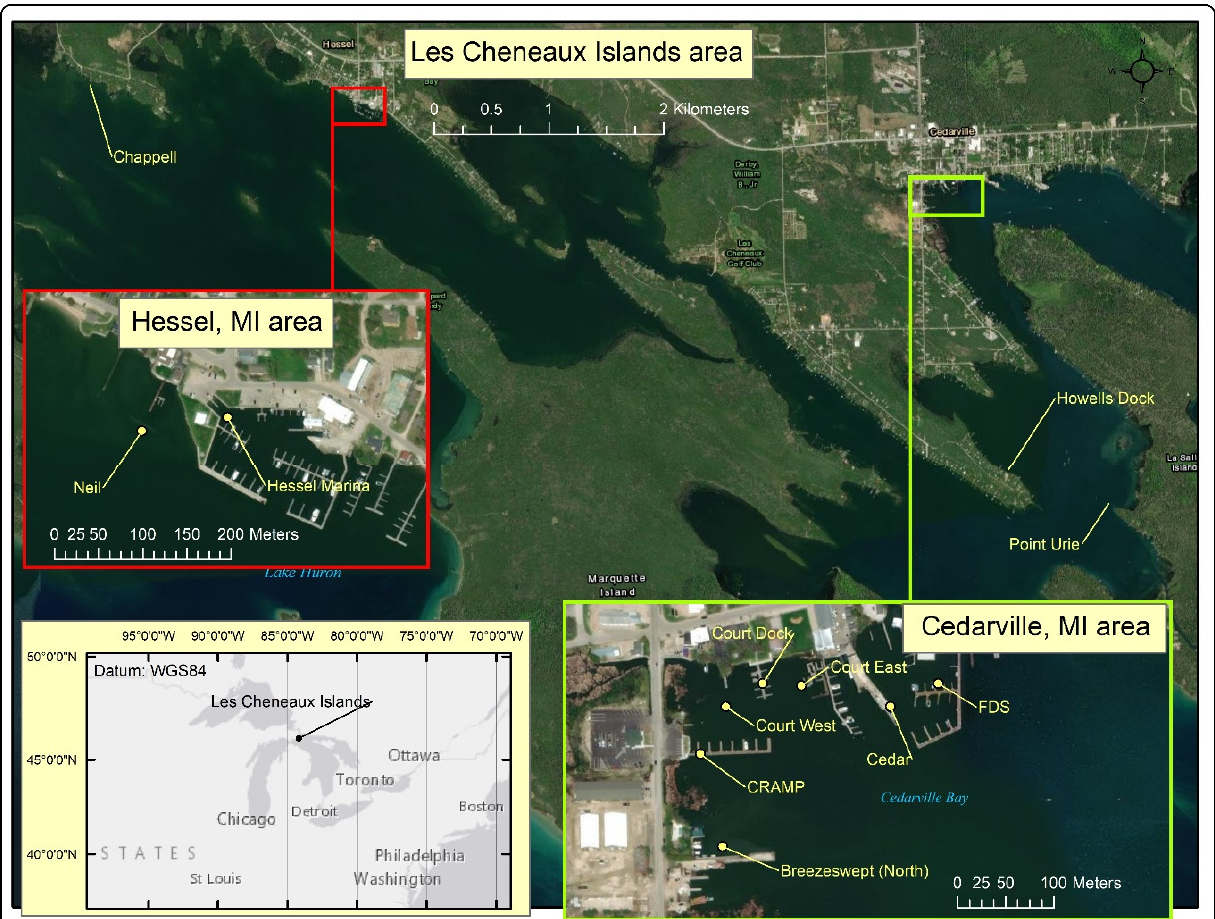
Figure 1. The Les Cheneaux Islands area in northwest Lake Huron, with data collection sites.